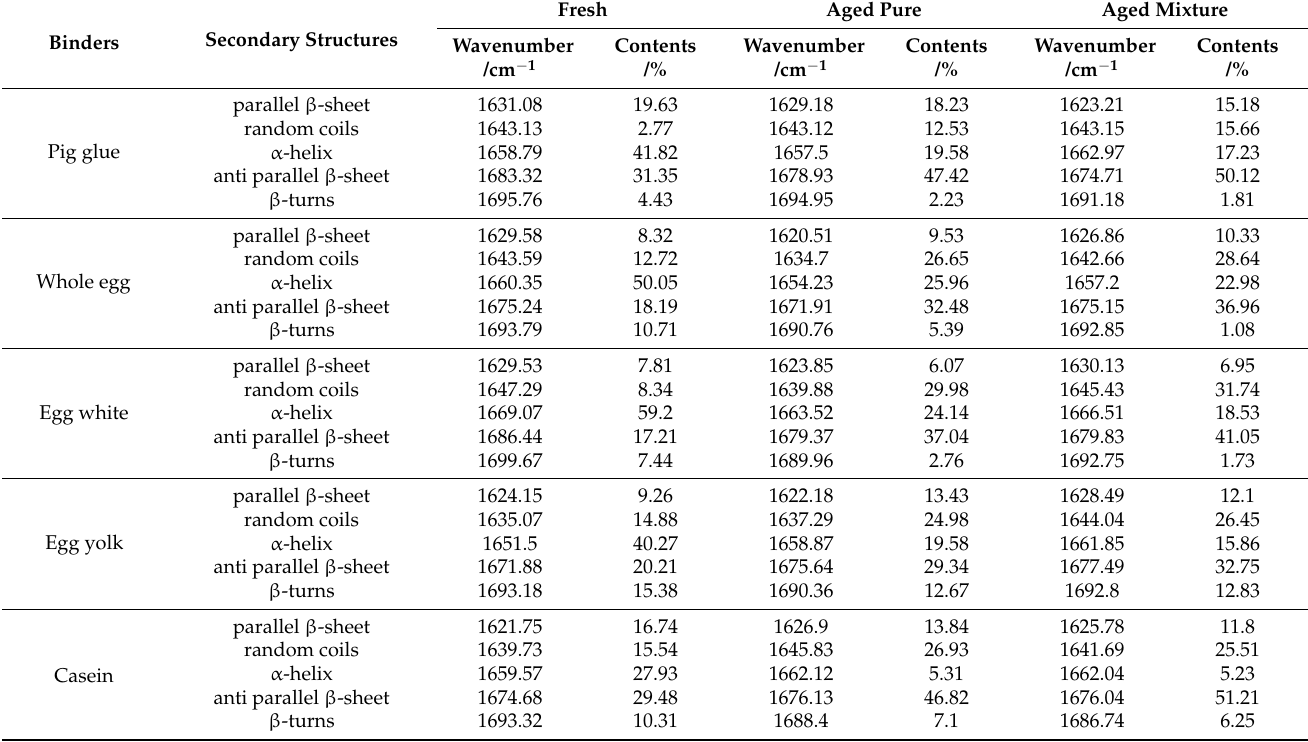
Table 4. The attributions and contents of the five secondary structures of the five fresh and aged